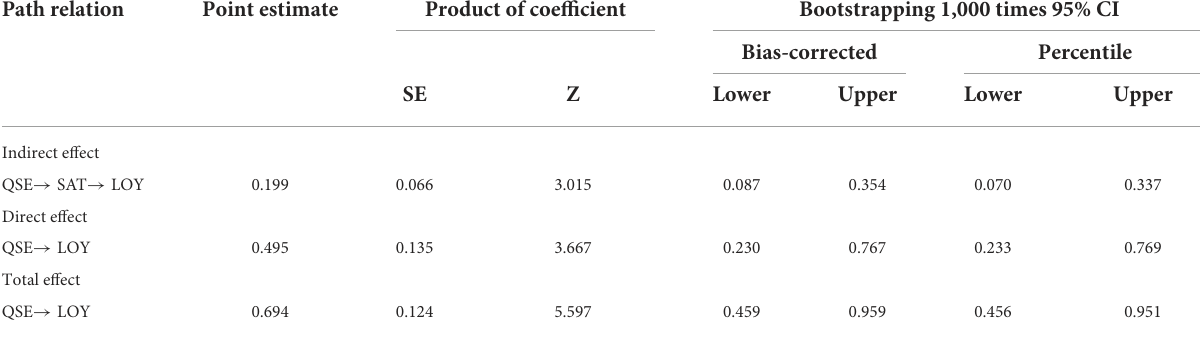
TABLE 7 Bootstrapping mediating effect testing.